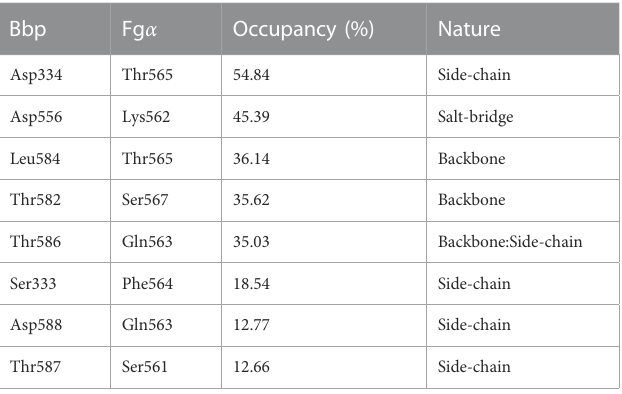
TABLE 1 Hydrogen bonds occupancy between Bbp and Fg α residues calculated and averaged before the main rupture event.